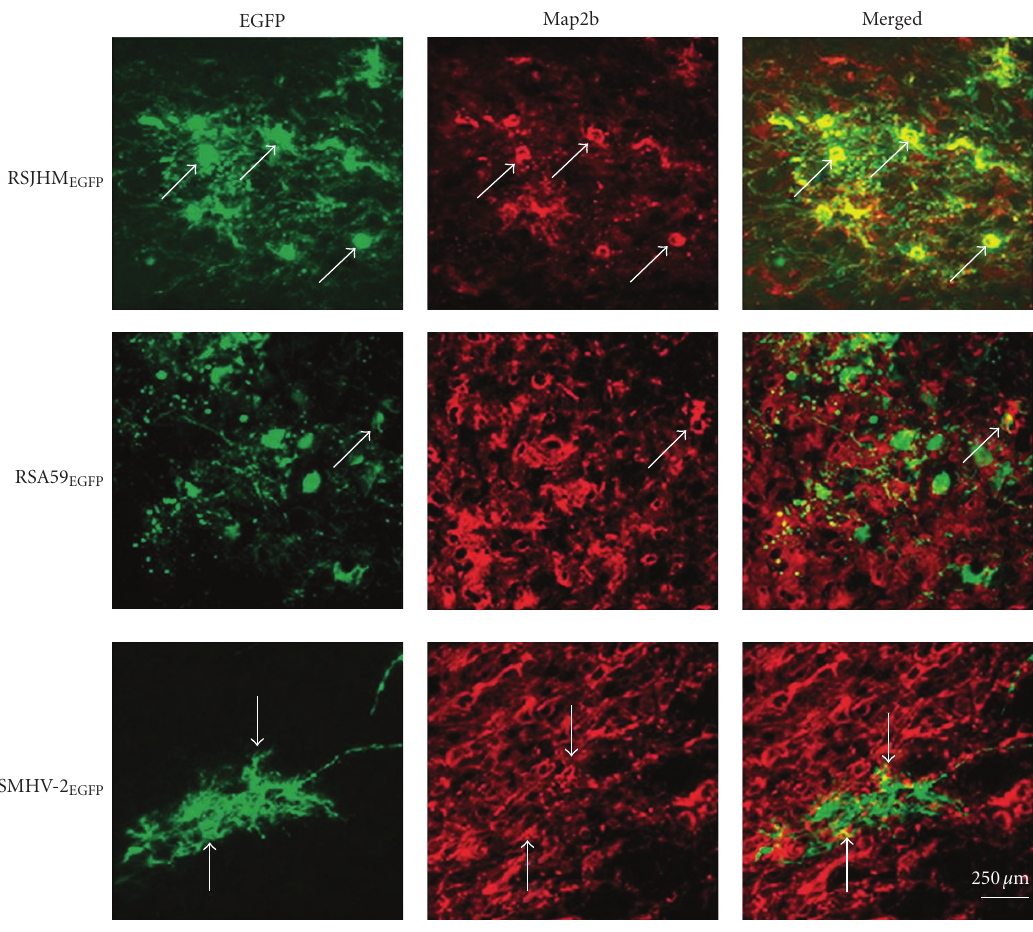
Figure 18: Identification of EGFP MHV-infected neurons in the brain at day 5 post infection. Mice were infected intracranially with RSJHM EGFP , RSA59 EGFP , and RSMHV2 EGFP . Infected mice were sacrificed at day 5 post infection, and the brains were processed, sectioned and then labeled with anti-MAP2b as primary antiboelies and with Texas red goat anti-mouse IgG as secondary antibodies. EGFP fluorescence (green) was used to detect viral antigen-positive cells in the basal forebrain. Red fluorescence shows the corresponding labeling of MAP2b in neurons. Merged images show colocalization of MAP2b and EGFP positive cells. Arrows identify cells double positive for viral antigen and MAP2b. Bar = 250 microns. (Adapted from the work of